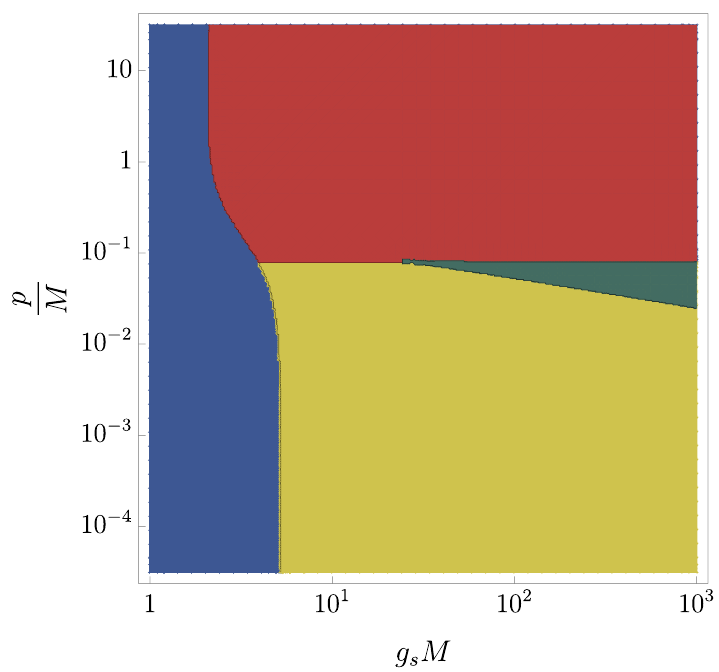
Figure 6. An exclusion plot of the existence of minima and maxima in V tot ( ψ ) . In the blue region the potential is negative everywhere. In the red region, a positive maximum exists, but it is in an uncontrolled regime. In the yellow region a positive maximum exists in a controlled regime. In the green region a metastable uplifting minimum